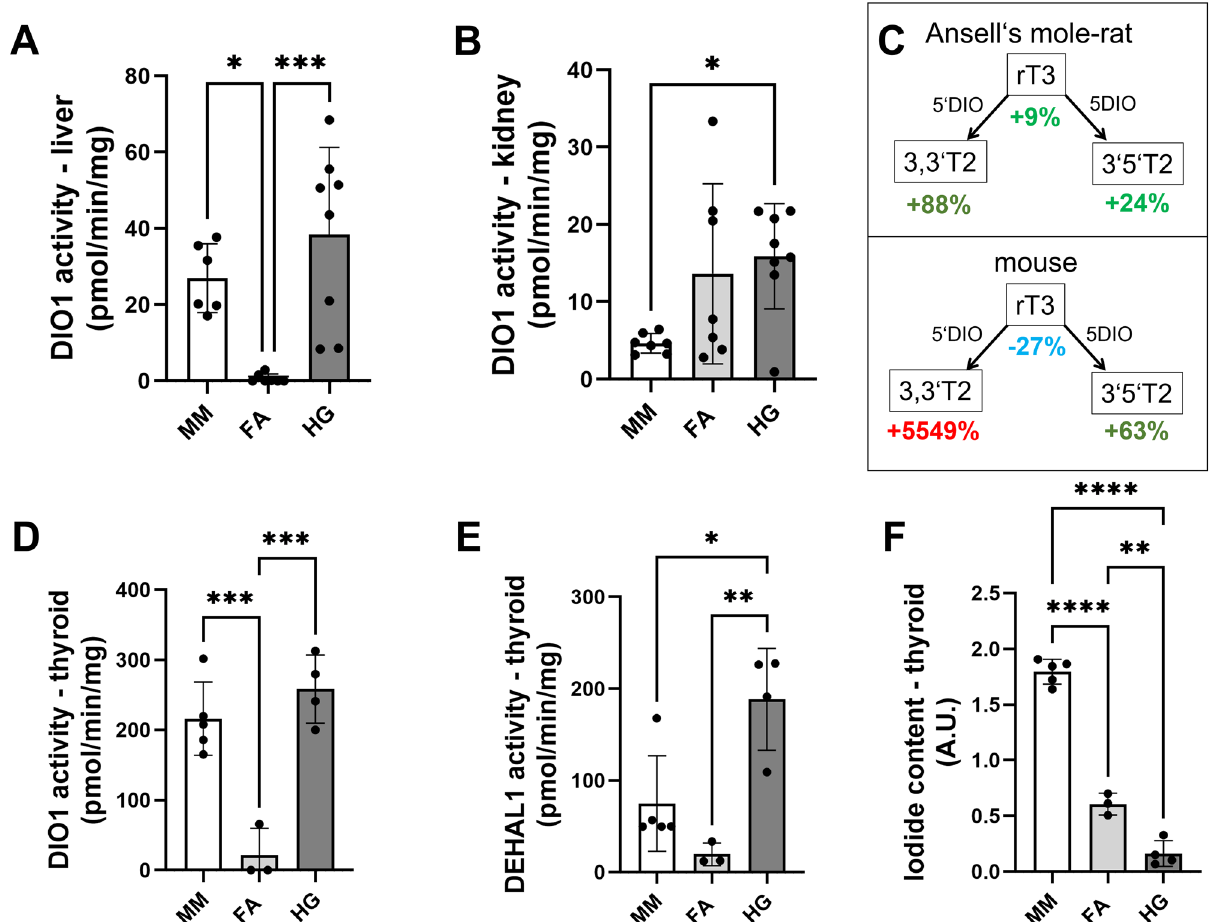
Figure 6. Comparison of deiodinase activity in mice, Ansell’s mole-rats, and naked mole-rats. Enzyme activity of DIO1 in ( A ) liver and ( B ) kidney in mice, Ansell’s mole-rats, and naked mole-rats based on determination of iodide release from rT3. DIO1 activity was determined as difference in enzymatic iodide release in absence vs presence of the DIO1-specific inhibitor 1 mM PTU of a pooled sample control per species and organ. Data are presented as mean ± SD. ( C ) DIO1 activity was verified in a subset of liver samples using LC–MS/MS as readout. In mice, a PTU-sensitive rT3 turnover was detected, while in liver of Ansell’s mole-rats, no increase of rT3 metabolites was observed. ( D – F ) Enzyme activities of ( D ) DIO1 and ( E ) DEHAL1 as well as ( F ) iodide content in thyroid gland. Statistical differences were analysed by one-way ANOVA followed by Tukey correction for multiple comparisons. Statistical significance was set at the level of p < 0.05 (*), p < 0.01 (**), p < 0.001 (***), p < 0.0001 (****). Data are presented as mean ± SD. MM, Mus musculus ; FA, Fukomys anselli ; HG, Heterocephalus glaber